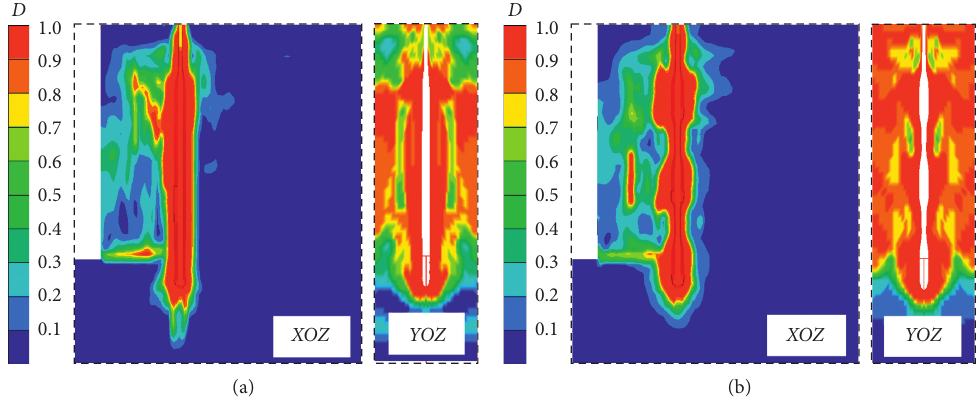
Figure 4: Blasting damage distribution under different charge patterns. (a) Normal blasting. (b) Water-decked blasting.